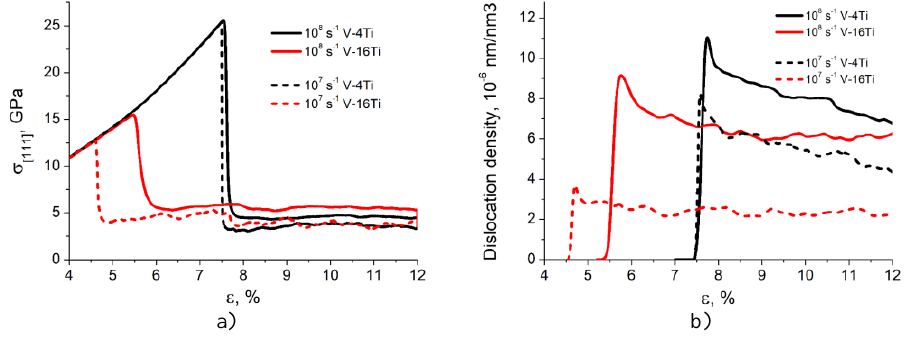
Fig. 3. Dependence of the compressive stress in the [111] direction (a) and dislocation density (b) on the magnitude of the compressive strain for crystallites of various stoichiometric